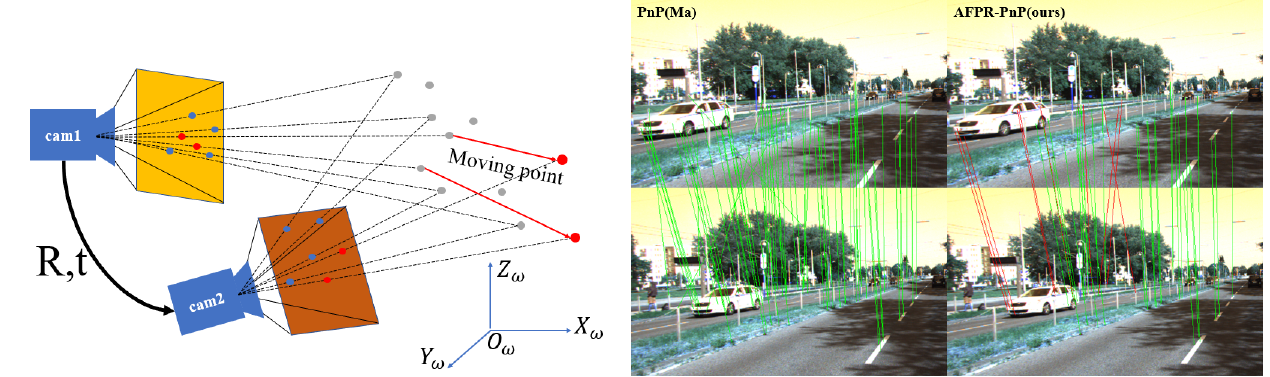
Figure 5. Automatic feature points’ refinement